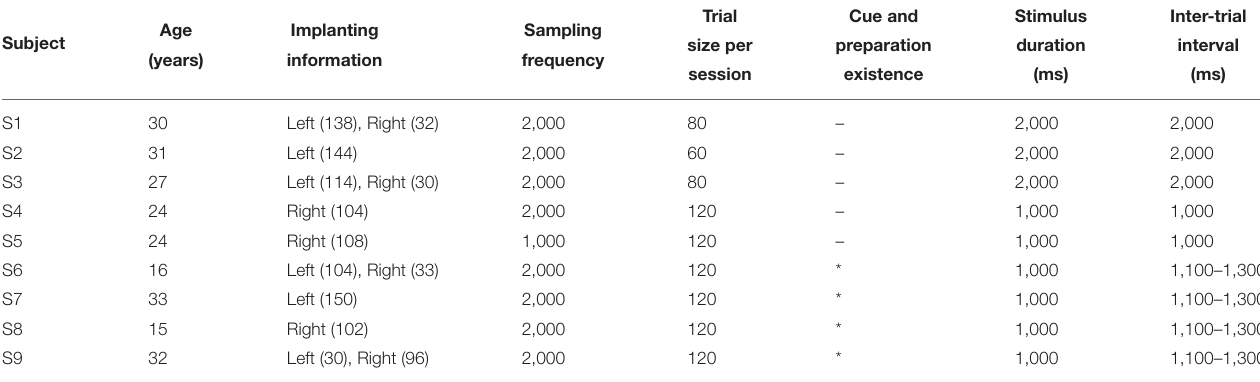
TABLE 1 | Subject demographics, implanting information, neural recording